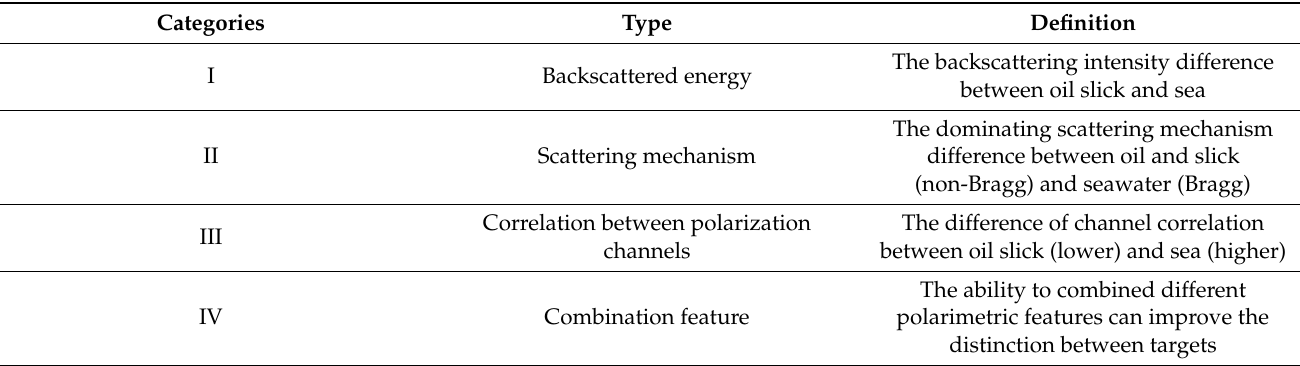
Table 1. Categories and definitions of polarimetric